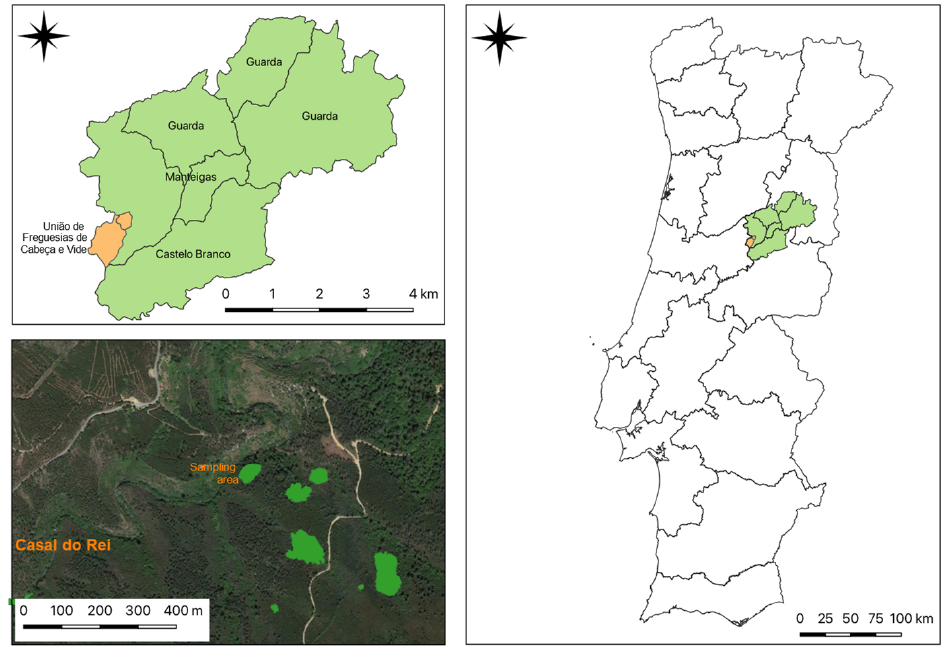
Figure 1. Location of the study and sampling area.